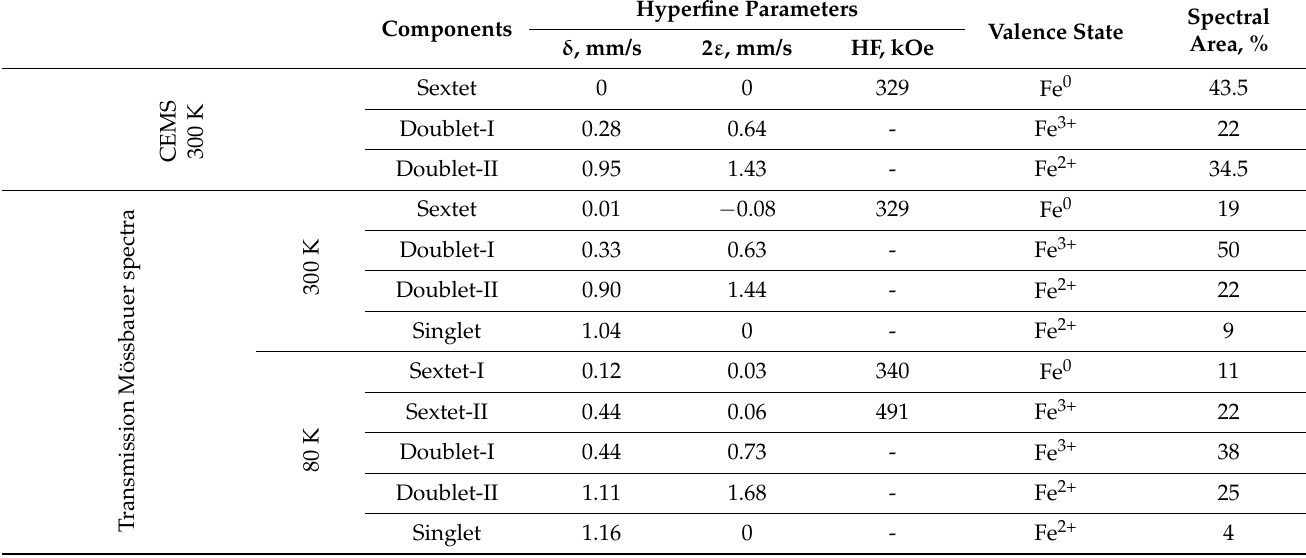
Hyperfine Parameters